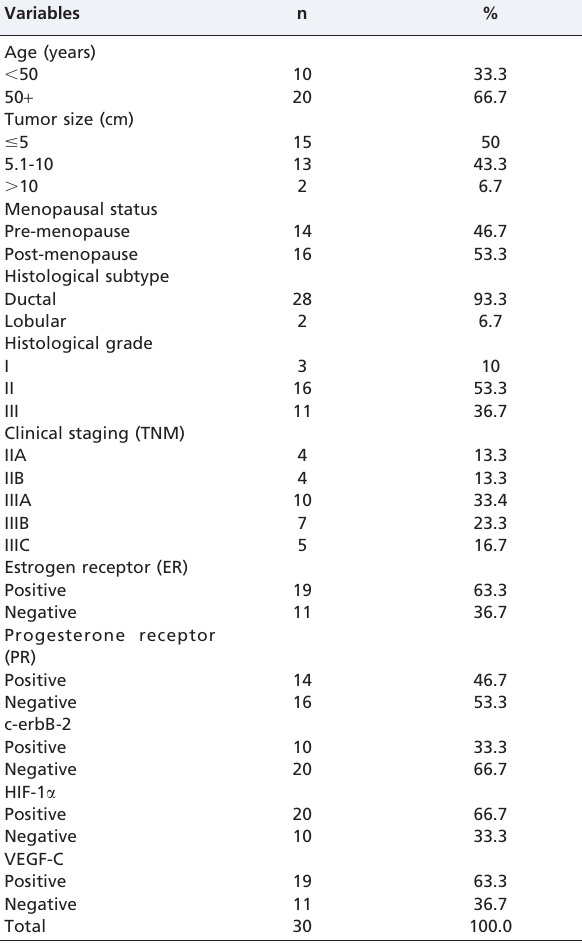
Table 1 - Baseline characteristics of the studied patients (Ribeira˜o Preto, Brazil,